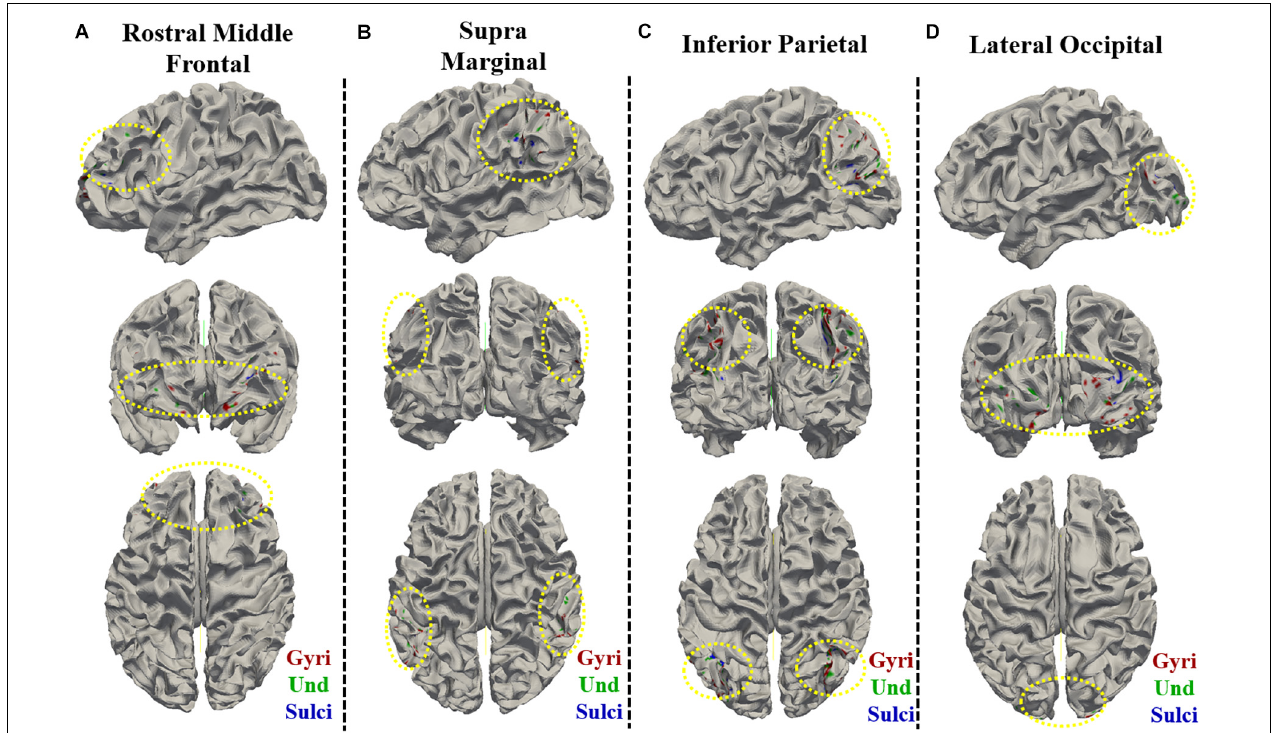
FIGURE 8 | Visualization of the vertices with significant positive correlation between temporal variance and the “number of correct responses” measure within single brain region on cortical surface of one subject. The vertices distribution on cortical surface are shown from three views within (A) Rostral Middle Frontal, (B) SupraMarginal, (C) Inferior Parietal, and (D) Lateral Occipital regions, respectively. The main locations of those vertices on cortical surface are highlighted by yellow dashed